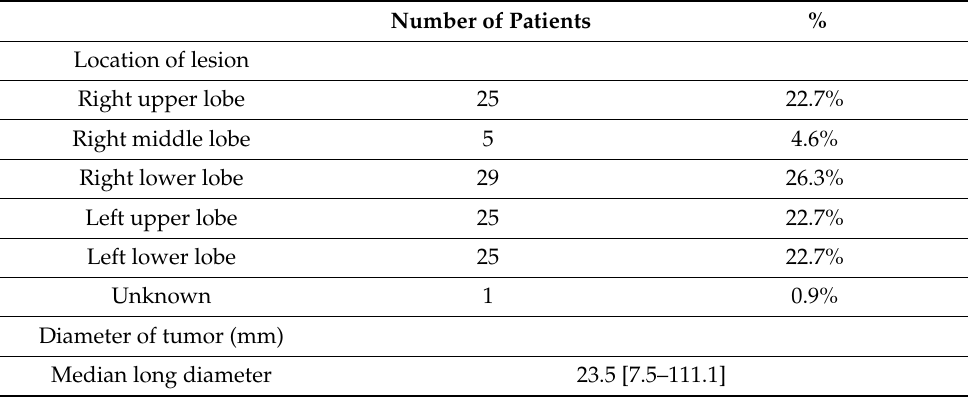
Table 2. Characteristics of parenchymal lung target